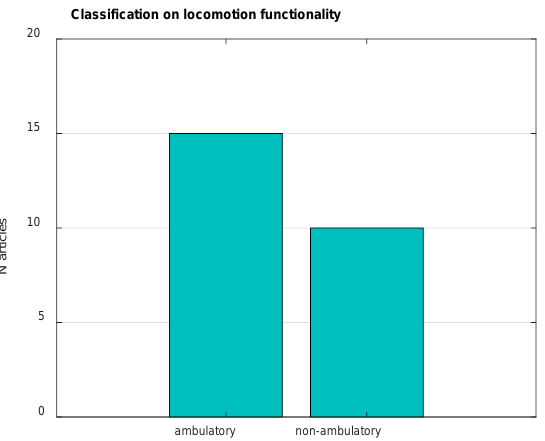
Figure 3. Experimental studies classification based on ambulatory and non-ambulatory patients. Table 2. Description of wearable sensors used in the studies.